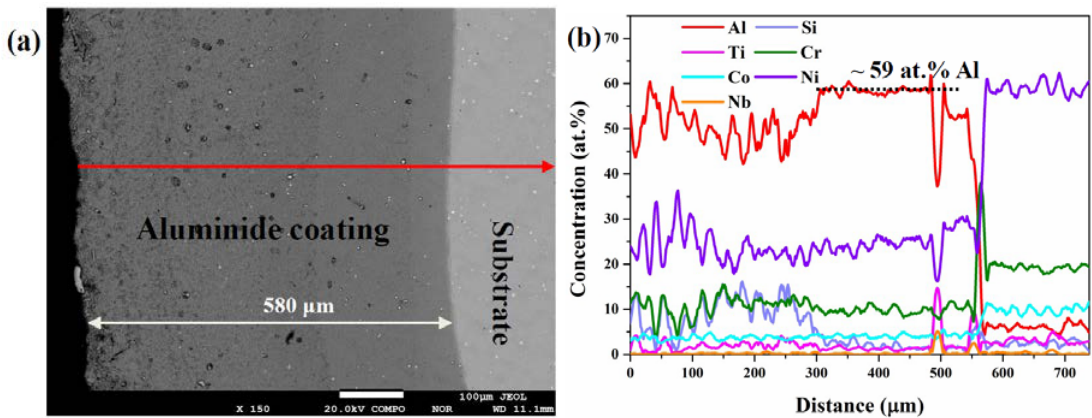
Figure 4. ( a ) Cross-sectional micrograph of the aluminide coating after been heat treated at 850 °C in argon for 24 h, and ( b ) corresponding energy-dispersive X-ray spectrometer (EDX) line profiles of the elemental distributions across the aluminide layer on an IN738 superalloy.